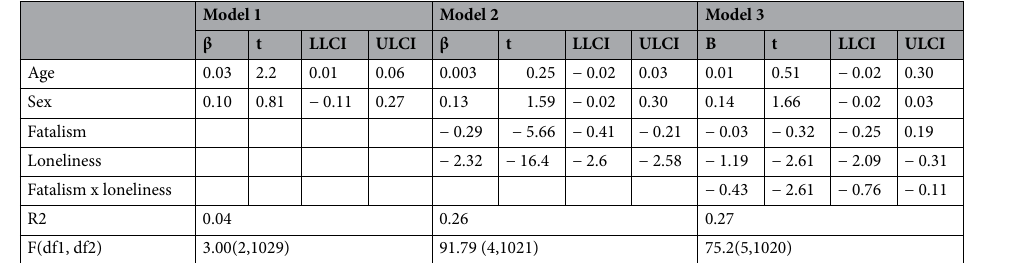
Table 3. Linear regression and Hayes’ linear regression analyses considering loneliness a moderator (dependent variable = quality of life).